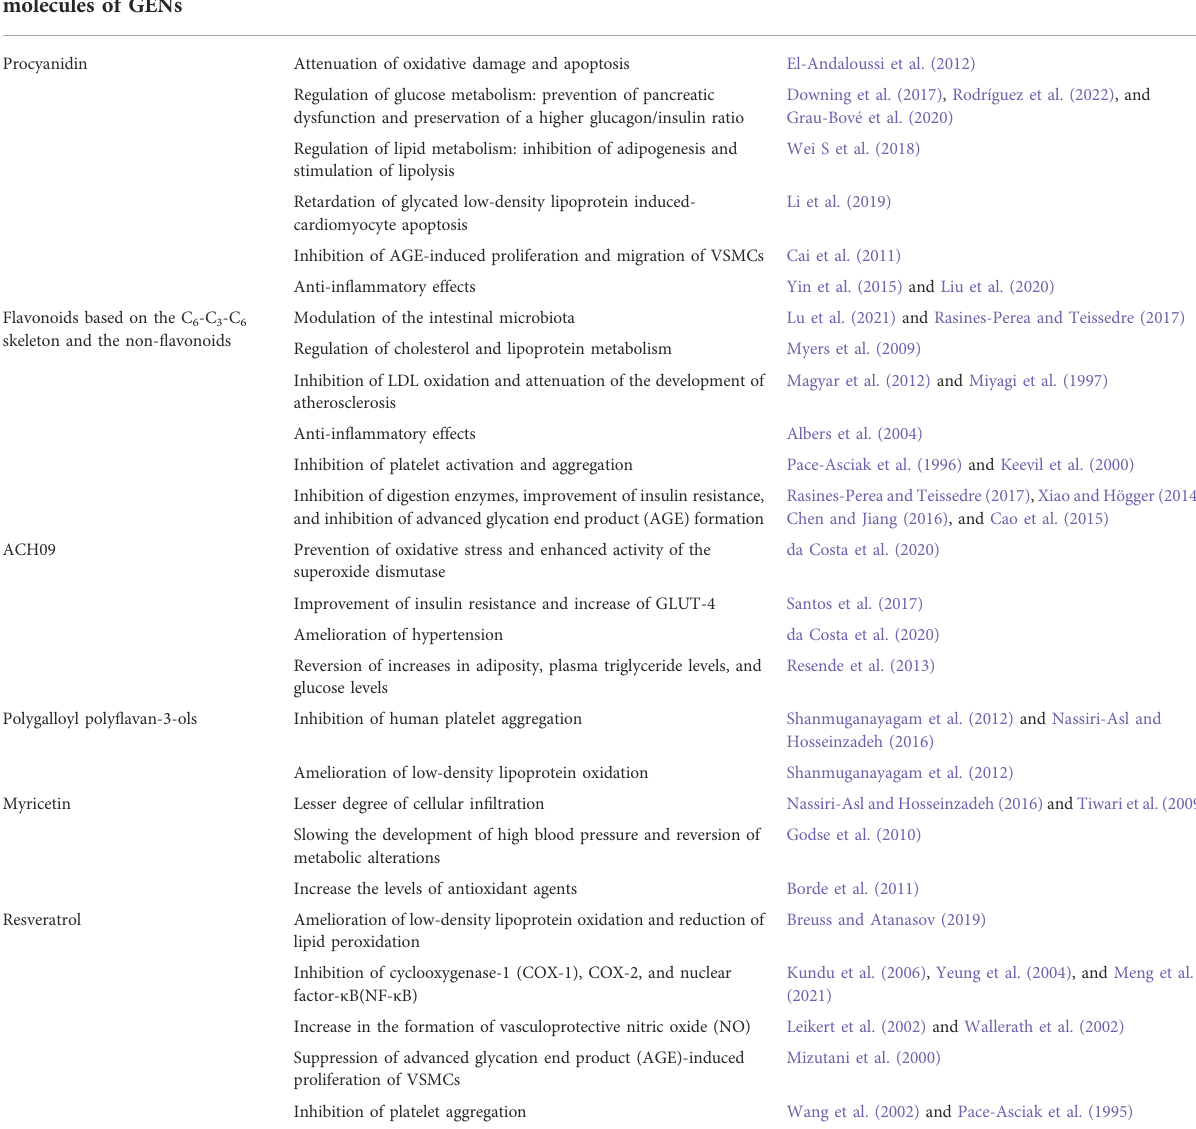
TABLE 1 Bioactive small molecules of GENs and their effects on the vascular system. Small molecules of